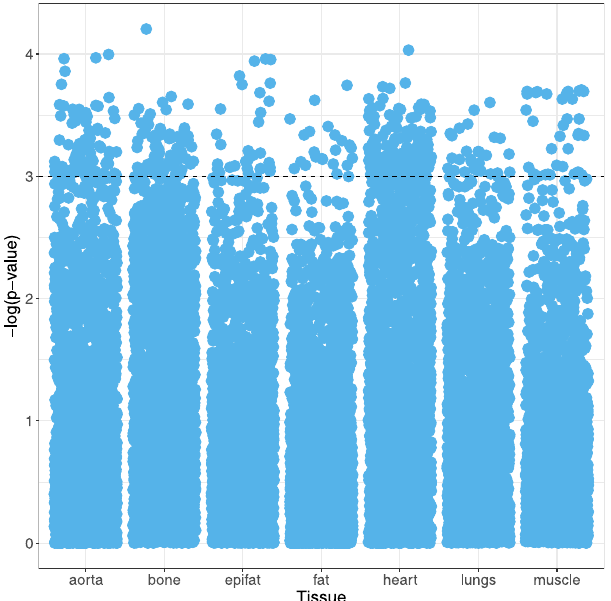
Figure 1. Manhattan plot showing the distribution of covariates in each tissue segment. The dotted line identifies the threshold of significance (the − log 10 of the p-value is plotted on the y-axis, covariates above this line have p-values < 0.05).